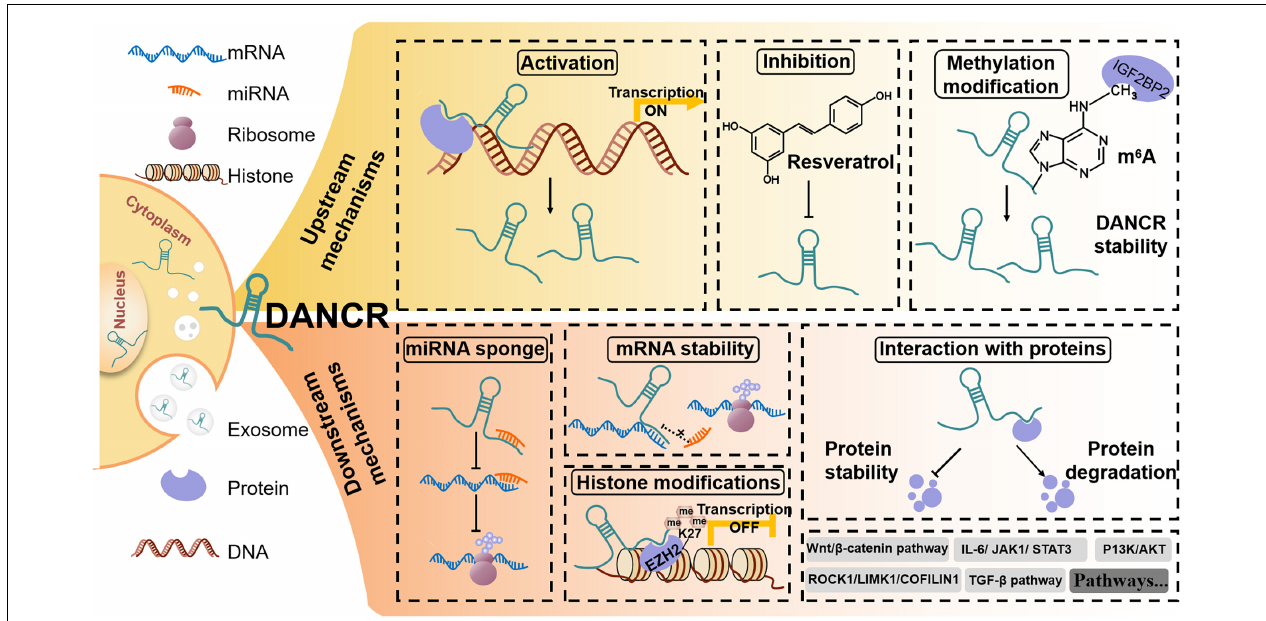
FIGURE 4 | The upstream and downstream regulatory mechanisms for DANCR in cancer. For upstream mechanisms, factors like proteins or drugs can regulate the expression of DANCR. Meanwhile, methylation modification can also regulate DANCR expression. For downstream mechanisms, DANCR can act to sponge miRNAs, stabilize mRNAs and interact with proteins, finally regulating the activation of many signaling